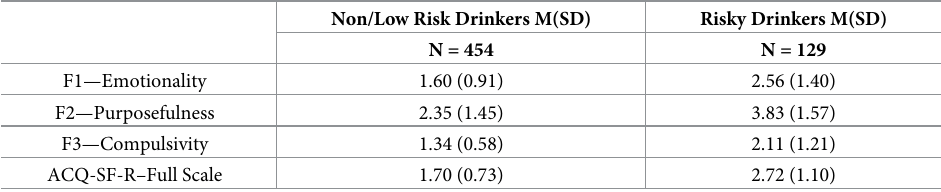
Table 5. Craving scores across alcohol use pattern